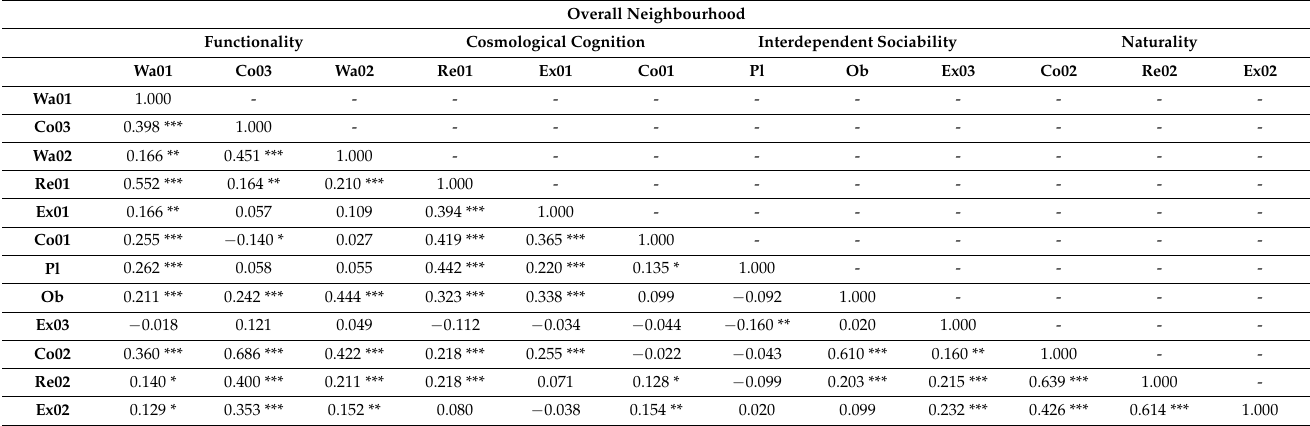
Table 11. The correlation matrix for determining the relevance of indicators on overall neighbourhood. Overall